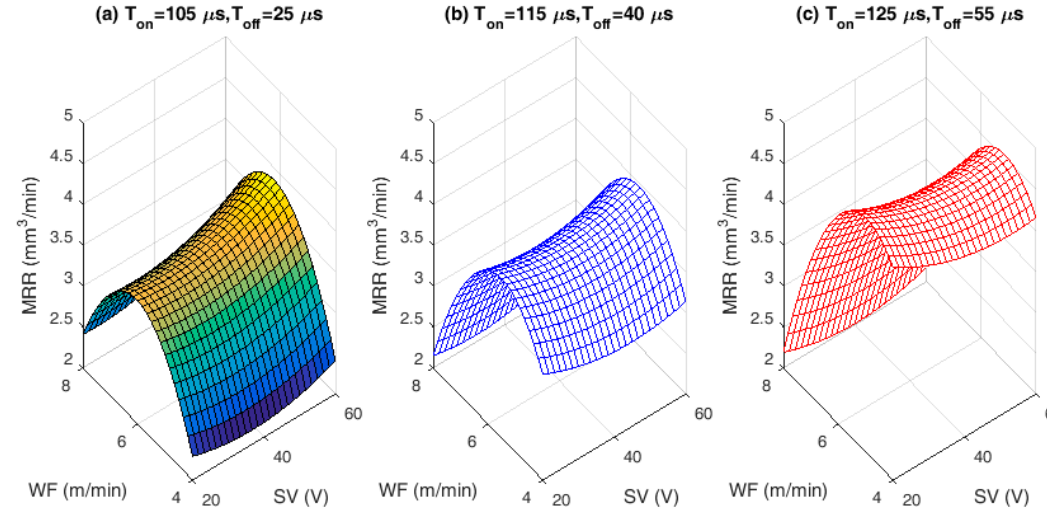
Figure 4. Interaction effects of input process variables on material removal rate (MRR): ( a ) Lower hold values of T on and T off . ( b ) Middle hold values of T on and T off . ( c ) Higher hold values of T on and T off .